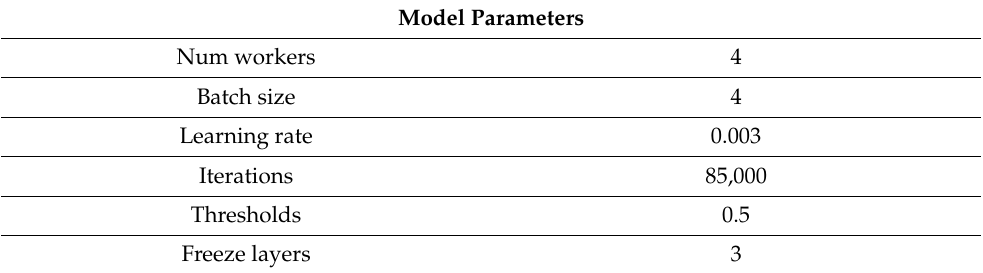
Table 1. The parameters used to execute the experiments for training and testing .